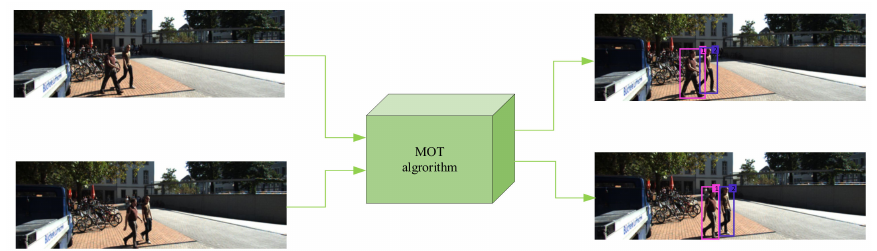
Figure 1. Sample output of the MOT